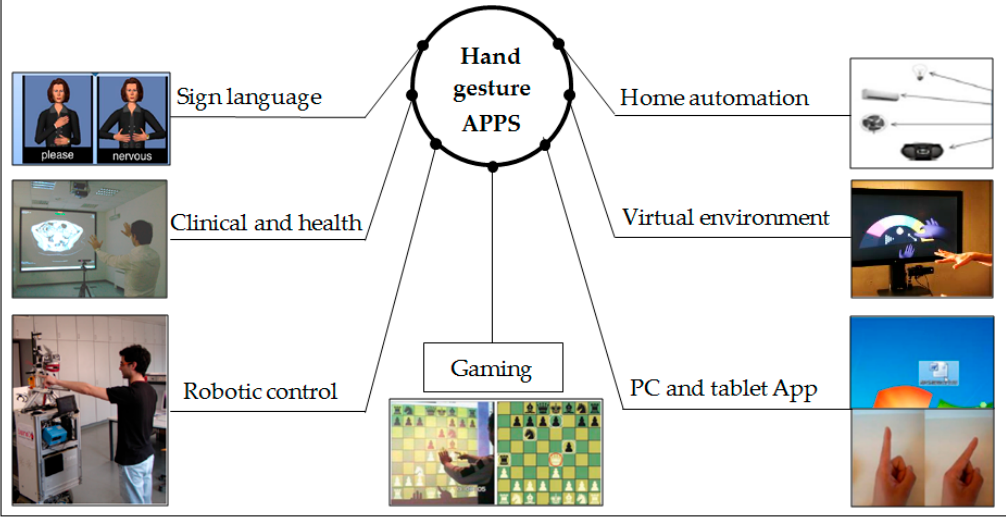
Figure 13. Most common application area of hand gesture interaction system (the image of Figure 13 is adapted from